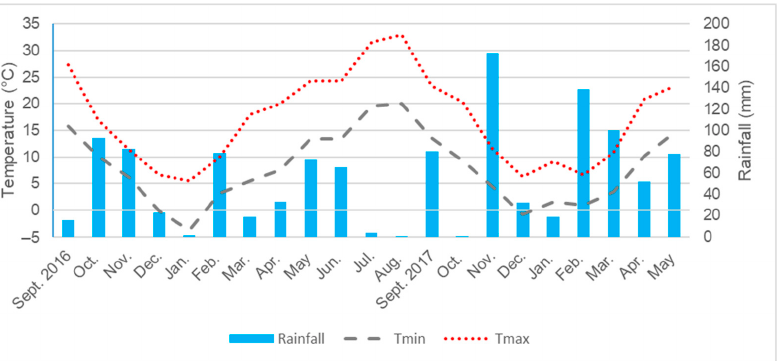
Figure 1. Monthly mean minimum (Tmin) and maximum (Tmax) air temperatures and total rainfall recorded during the two growing seasons.